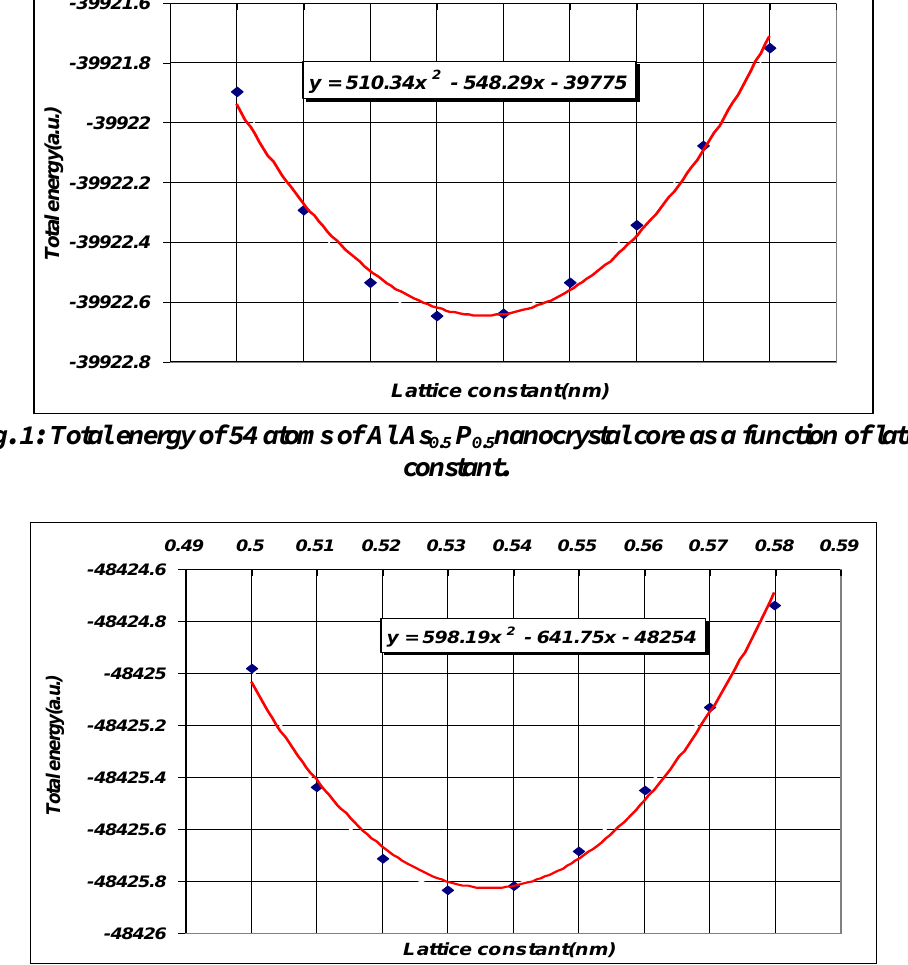
P nanocrystal core as a function of lattice 0.5 0.5